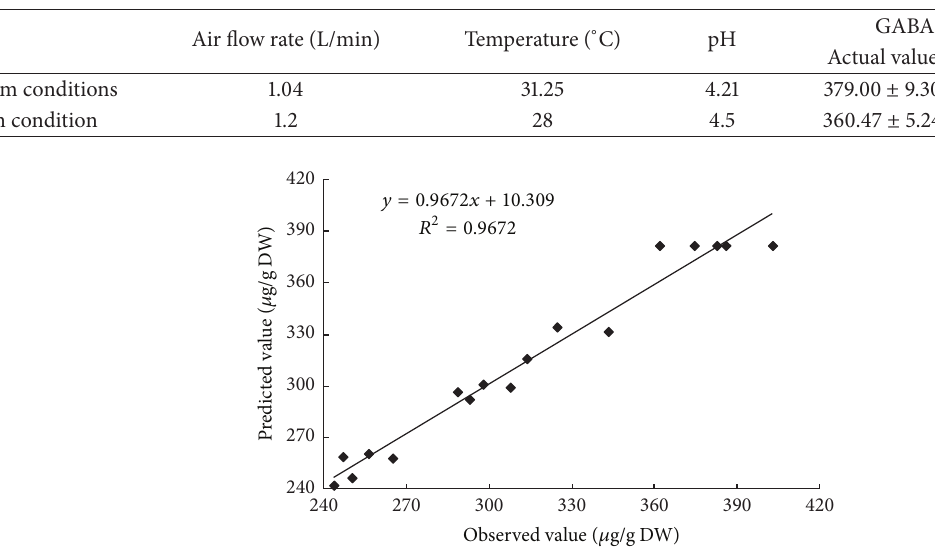
Table 5: Arrangement and result of confirmatory trials.